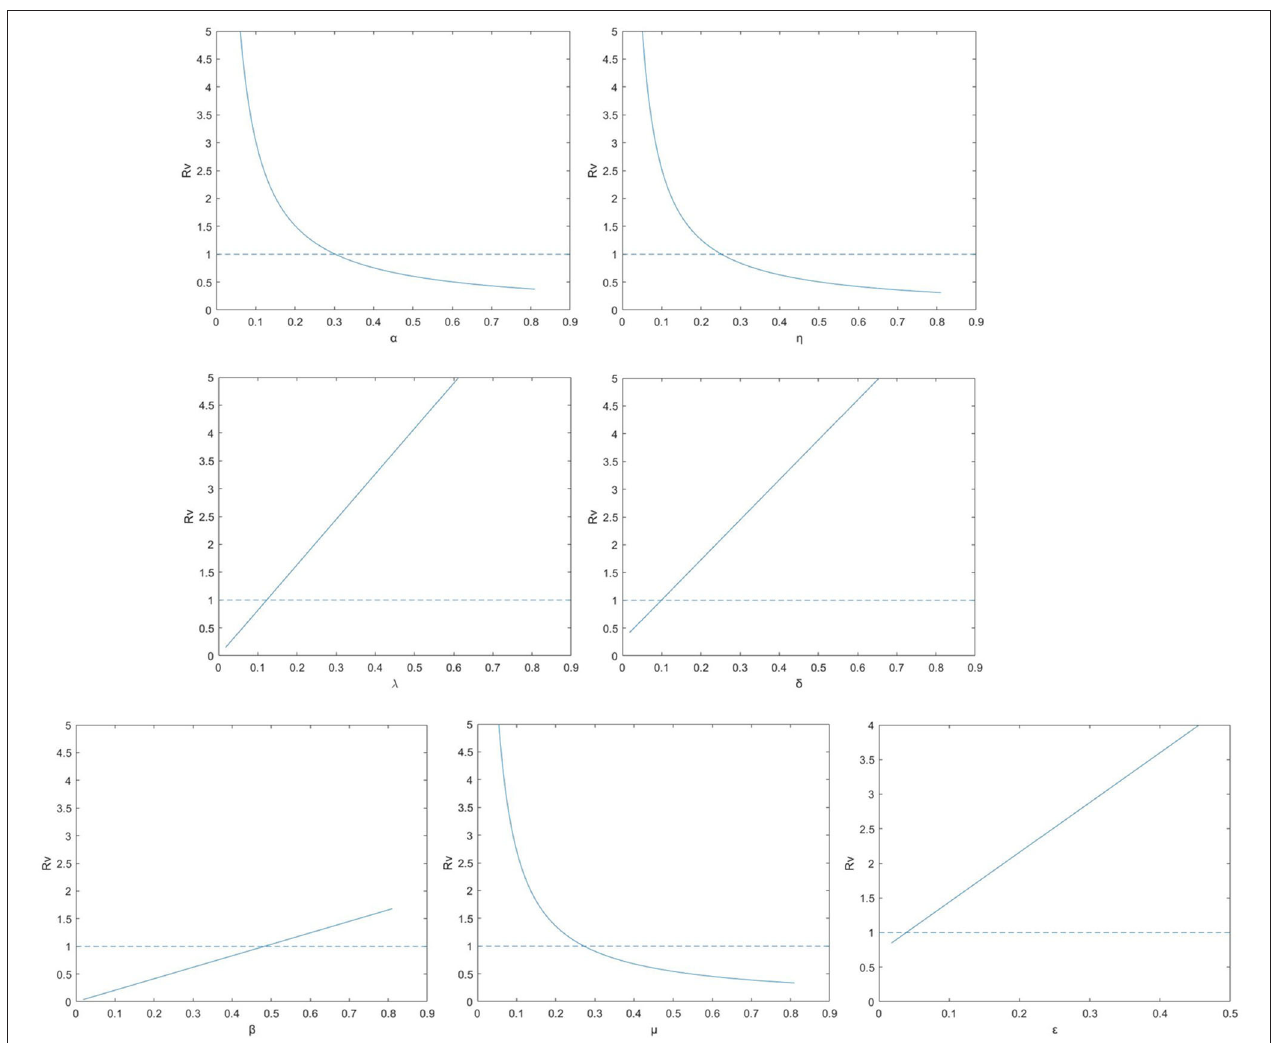
FIGURE 2 | The control reproduction number R V for model (1) (solid lines) for the relevant model with vaccination according to parameters λ , δ , ε , β , α , η , and µ